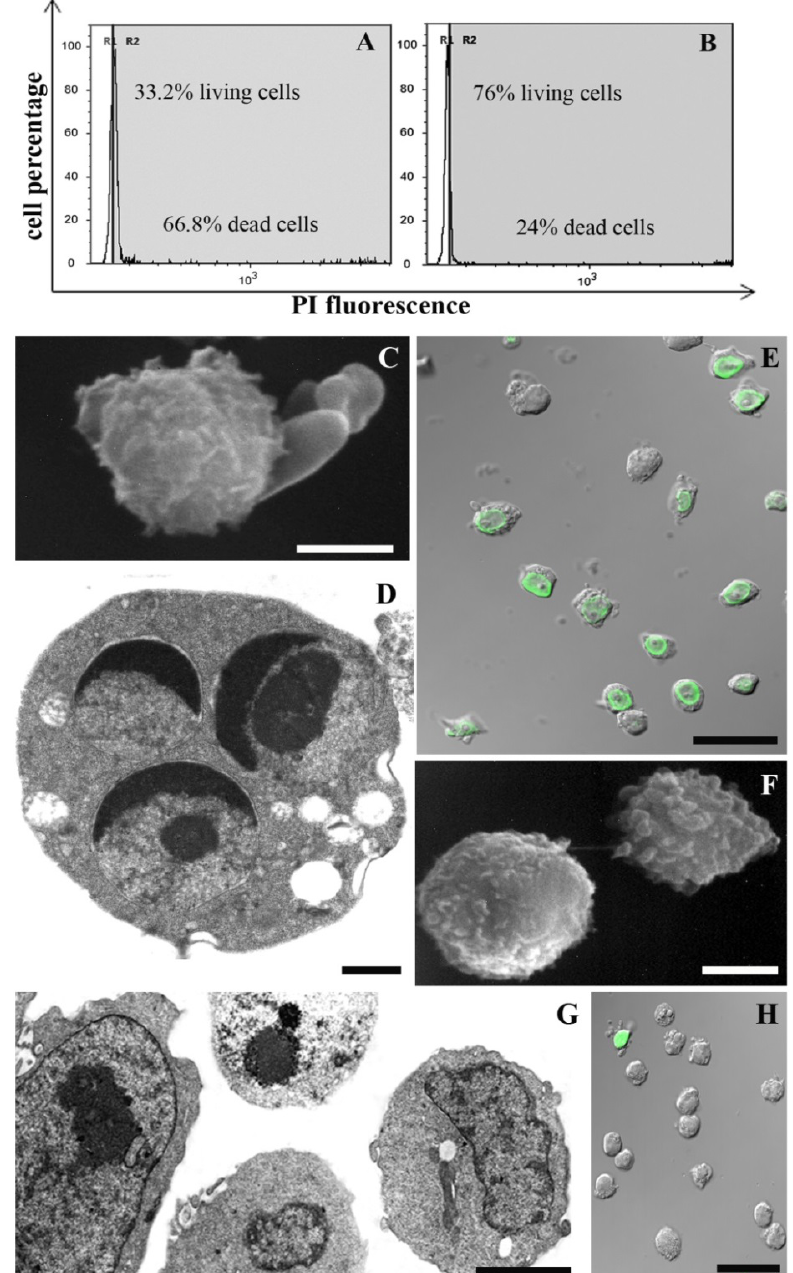
Figure 3. Cells exposed to staurosporine ( A , C – E ) or MEL + staurosporine ( B , F – H ), analysed by means of supravital PI ( A , B ), SEM ( C , F ), TEM ( D , G ) and CLSM ( E , H ). The trigger induces an evident cell death increase ( A ); apoptotic features can be observed after ultrastructural analyses ( C – E ). MEL added before staurosporine treatment restores cell viability ( B ) and morphology ( F , G ) and prevents DNA fragmentation in situ ( H